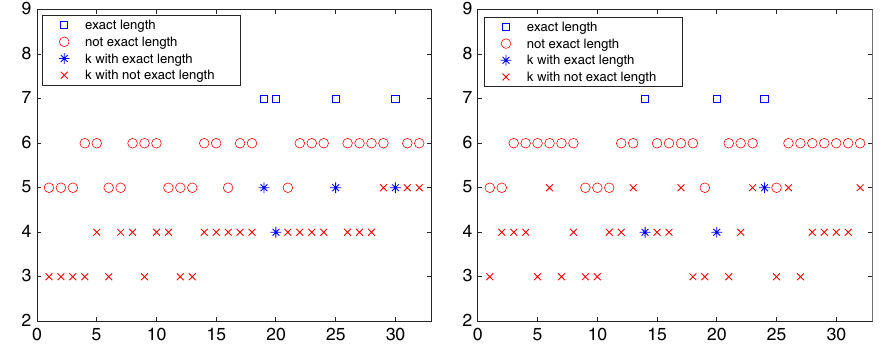
Fig. 10 Network ibm32: the chain length and lower bandwidth of the { ℓ , k } -chained structure determined by the out-tree (left) and the in-tree (right) rooted at each vertex v j , j = 1,2, ...